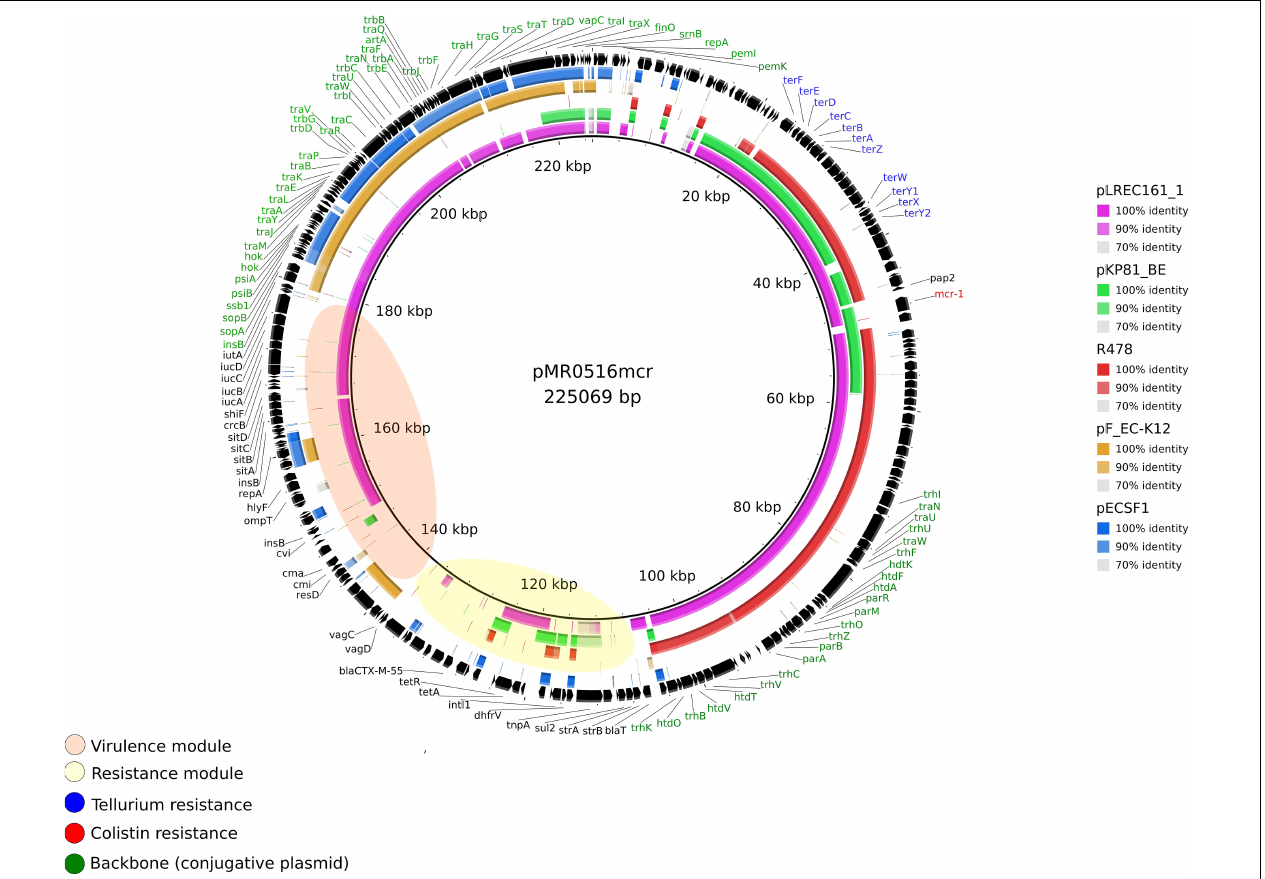
FIGURE 3 | Structural comparison between mcr-1 plasmids, IncF, and IncHI2 references. The alignment includes four references and the one IncF mcr -1–bearing plasmid found in our study. pMR0516mcr (IncF) was used as a reference to match with the other plasmids with [pKP81_BE (IncF)] and without mcr-1 gene [IncF plasmid from Escherichia coli K12, pECSF1 (IncF) and R478 (IncHI2)]. The outer circle with black arrows denotes the annotation of pMR0516mcr. The image was generated using BRIG (default parameters with 90/70 as upper/lower